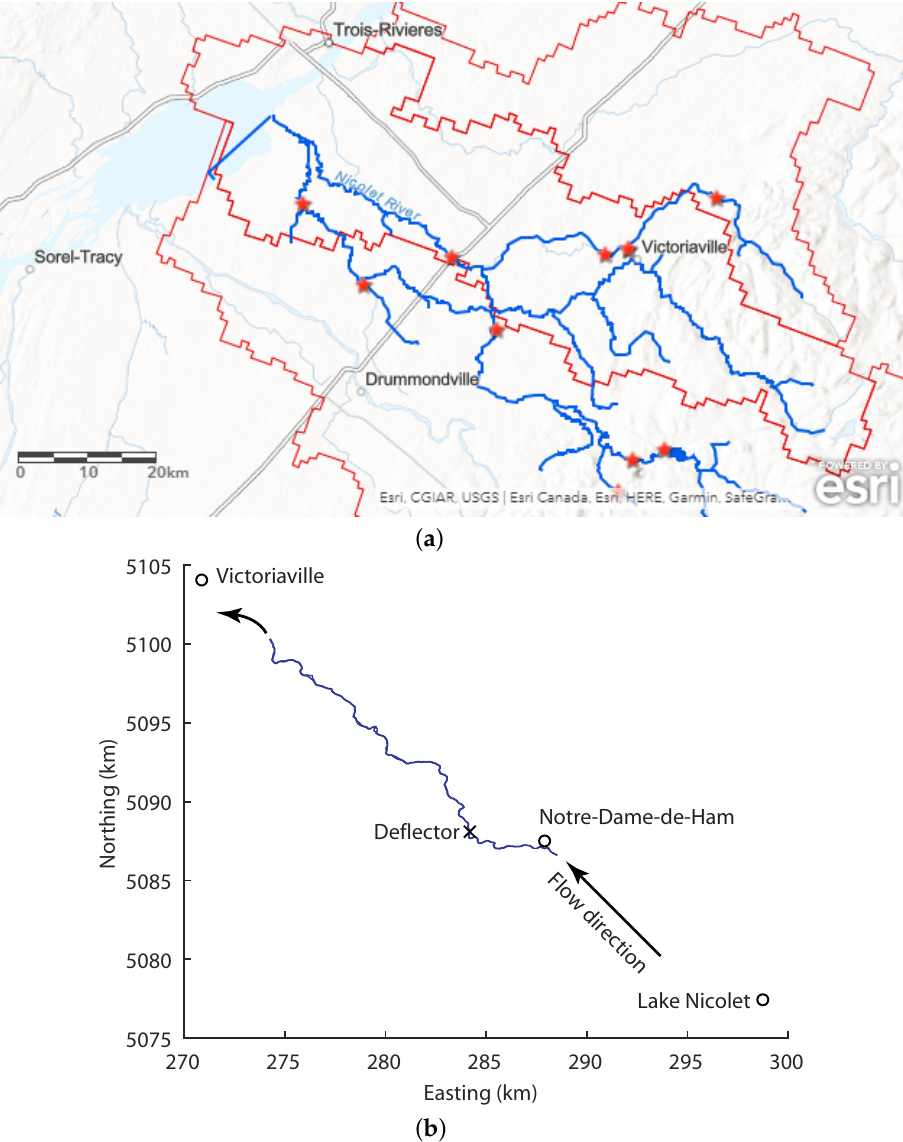
Figure 1. ( a ) The Nicolet River watershed in the Province of Quebec, Canada. The river flows from Lake Nicolet through Victoriaville to the river mouth in Lake Saint-Pierre between Sorel-Tracy and Trois-Rivieres. ( b ) A 26 km section of the river channel as the site of this